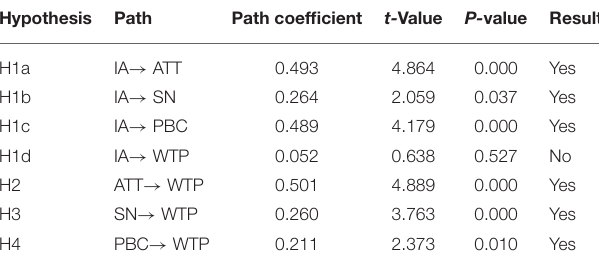
TABLE 6 | Results for the hypothesis model. Hypothesis